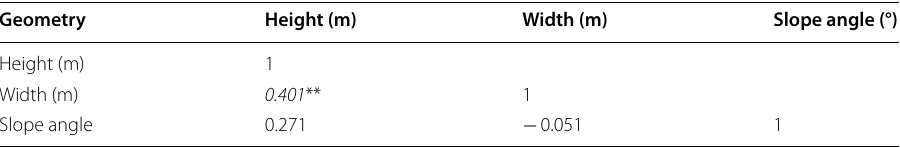
Table 8 Slope geometry correlation